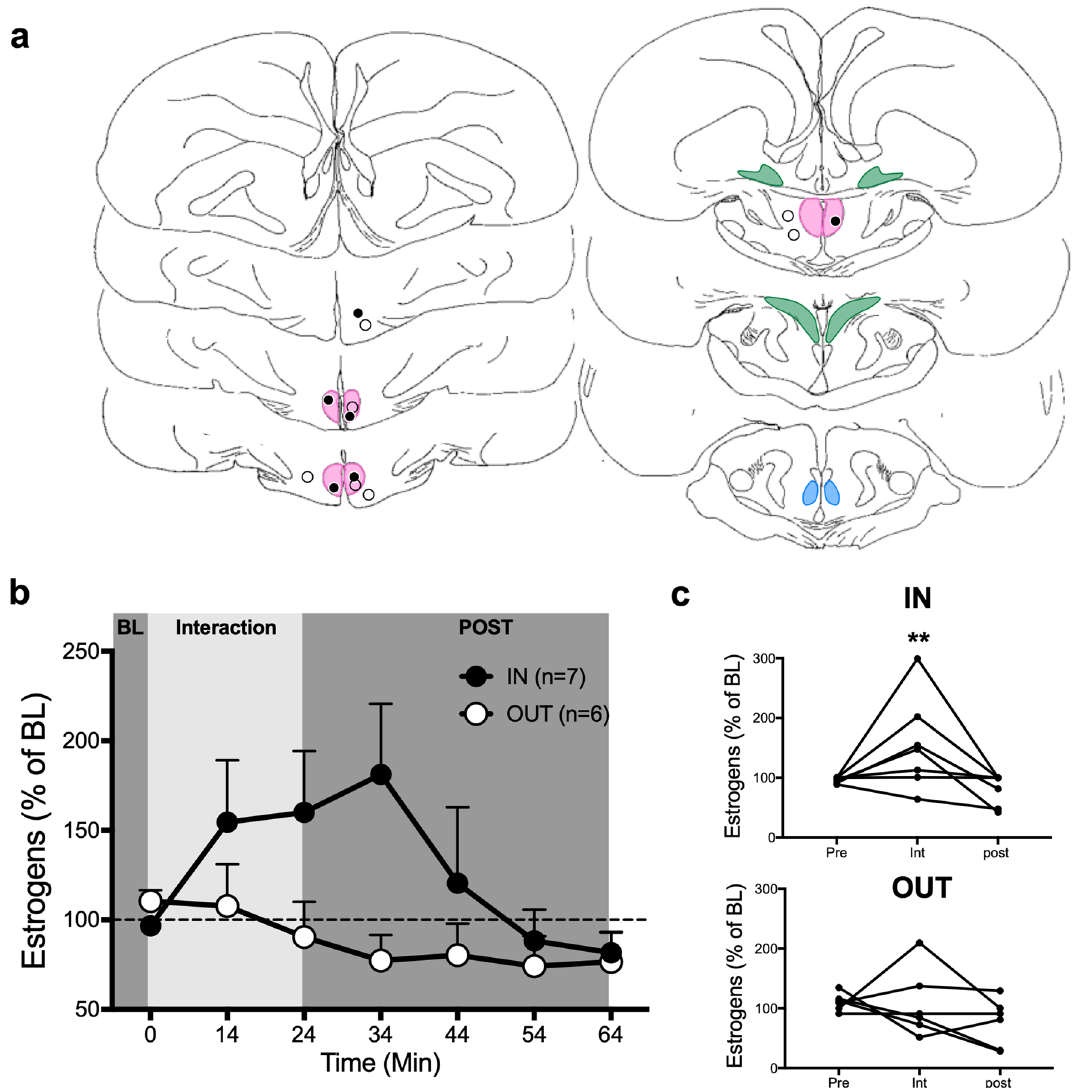
Figure 6. Changes in local estrogen concentration are detected within 10 min of sexual interaction in medial preoptic nucleus (POM) but not outside. ( a ) Schematic representation of coronal sections of the quail brain showing the location of the dialysis probes. IN probes are either within or touching the colored zones representing brain regions expressing aromatase. See legend of Fig. 1 for the definition of different brain areas. Black and open circles respectively represent birds in which estrogen concentrations did or did not increase above 150% of the baseline (BL) during the interaction period. ( b ) Mean time course of changes of estrogen concentration in the dialysate during the course of the experiment expressed as the percentage of estrogen change based on the mean concentration measured in the last 3 BL samples. BL represents the last point of the 60 min baseline period during which samples were collected every 10 min. IN: Birds with the probe in POM, OUT: Birds with the probe outside any aromatase expressing cell populations. POST: post- interaction period. Friedman ANOVA: IN, χ 2 n=7 = 19.58, p = 0.0033; OUT: χ 2 n=7 = 5.837, p = 0.4417. No post hoc comparison reached significance. ( c ) Individual percent changes in estrogen concentration relative to BL in the three sampling periods for animals whose probe was within or outside POM. Friedman ANOVA (POM: χ 2 n=7 = 6.348, p = 0.0501; OUT: χ 2 n=6 = 0.9774, p = 0.6559; post hoc : **p < 0.01 vs POST). The baseline amounts of estrogens per sample in this experiment ranged between 0.053 and 0.315 pg per sample (10 µl; Mean ± S.E.M. = 0.147 ± 0.024, n = 13). Panel ( a ) is composed of home made drawings onto which probe positions were reported using Graphic for Mac (https:// graph ic. com/ mac/), other panels were created with Graph Pad Prism 8 (https:// www. graph pad. com/ scien tific- softw are/ prism/). All panels were assembled in